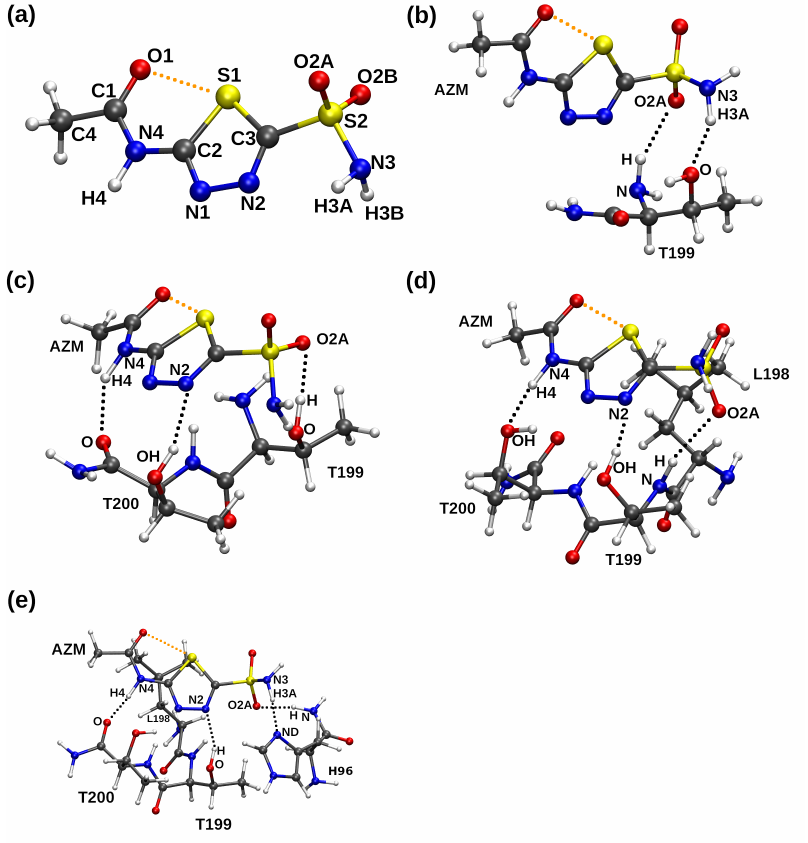
Figure 2. Molecular structure of ( a ) acetazolamine (AZM), and its complexes with CA IX mimic binding pocket ( b ) AZM-T, ( c ) AZM-TT, ( d ) AZM-TTL and ( e ) AZM-TTLH. The atoms coloring scheme is as follows: carbon—gray, oxygen—red, nitrogen—blue, sulfur—yellow, hydrogen—white. Hydrogen bonds are denoted as black dotted lines, while the chalcogen bonds are shown as orange dotted lines. The atoms numbering scheme used in the text is shown as well. The numbers of amino acids involved in the interactions with AZM molecules are